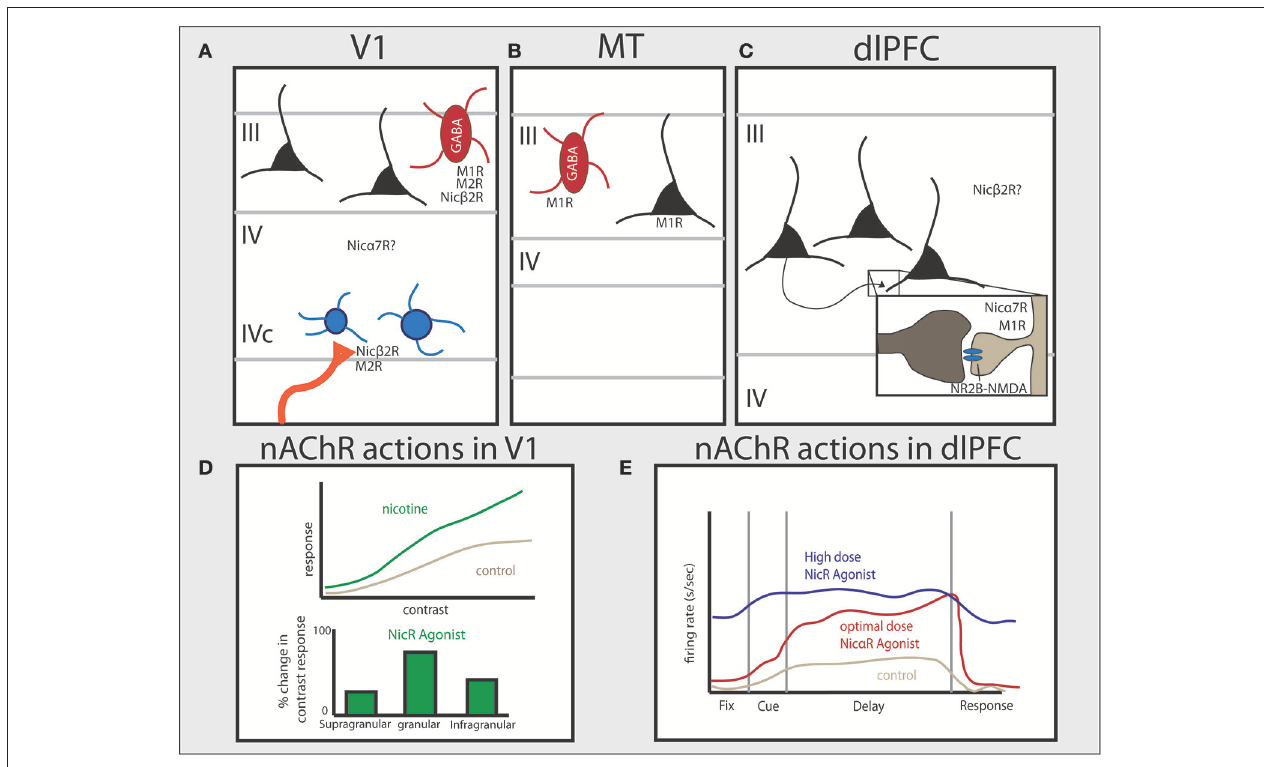
FIGURE 2 | Distribution of cholinergic receptors across cortical regions in primate and their physiological functions. Studies in primate have shown unique patterns of receptor expression for both nicotinic and muscarinic cholinergic receptors between cortical areas. (A) In V1 muscarinic receptors are expressed by GABAergic cells (M1 and M2) or presynaptically (M2), and nicotinic β 2-containing receptors are predominantly expressed presynaptically on thalamocortical terminals. Nicotinic α 7 receptors are also expressed in V1 but their precise localization is still unclear. (B) In area MT, M1 receptors are expressed by both GABAergic cells and the majority of excitatory pyramidal cells. (C) In layer III of dlPFC, NMDAR-NR2B are found within the PSD of glutamate spine synapses. Muscarinic receptors are found within or near the PSD on spines (M1) or presynaptically on presumed ACh terminals (M2). Nicotinic α 7 receptors are also found within or near the PSD on spines in primate layer III dlPFC. The specific distribution pattern of α 4 β 2 receptors in primate PFC is unknown. (D) The effect of nicotinic receptor activation in monkey and tree shrew V1, based on data from Disney et al. (2007) and Bhattacharyya et al. (2012), showing that activation of nicotinic receptors significantly increases gain response in layer IV, but not in other layers. (E) Data from dlPFC based on Yang et al. (2013) showing that nicotinic α 7 receptor stimulation enhances Delay cell persistent firing at optimal doses. See text for more